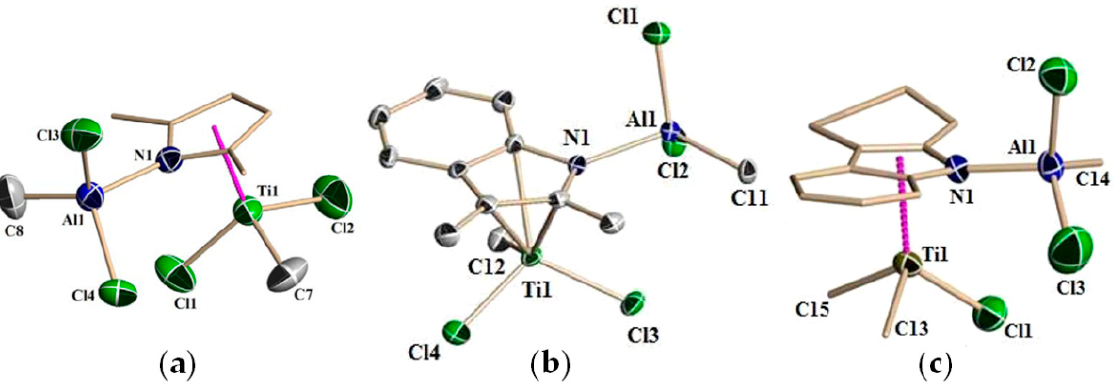
Figure 3. Molecular structures of Ti(IV)–Al–pyrrolyl complexes: ( a ) Ti09 ; ( b ) Ti10 ; ( c ) Ti11 . Reprinted with permission from [82]. Copyright (2012) American Chemical Society.